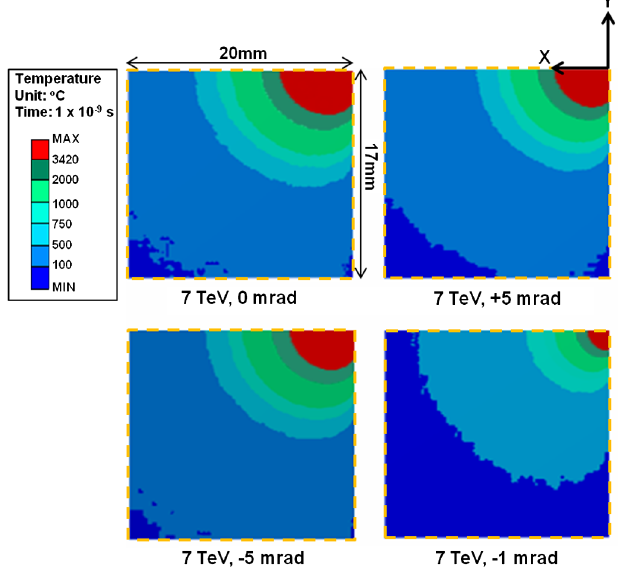
FIG. 15. Temperature peak profiles along the beam direction for the different jaw error cases. The melting temperature of the jaw inserts is marked at 3420 °C, assuming pure W for the jaw insert material. The reason for the dashed graph lines above the melting temperature is that the simulated temperature values are realistic only in the solid material part of the component.